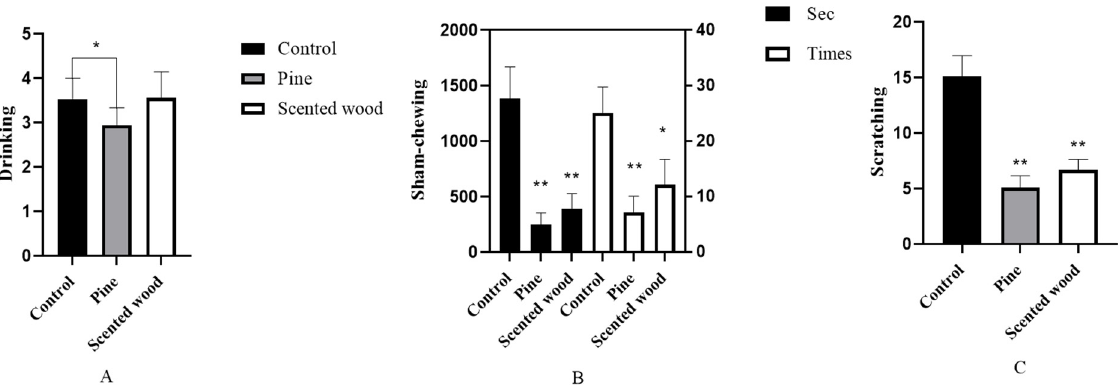
Figure 4. ( A ) The frequency of water drinking. ( B , C ) The frequency of sham-chewing and scratching behaviors. * p < 0.05 and ** p < 0.01 in enrichment item groups vs. control group. The data are ex- pressed as mean ± SEM (n = 10).